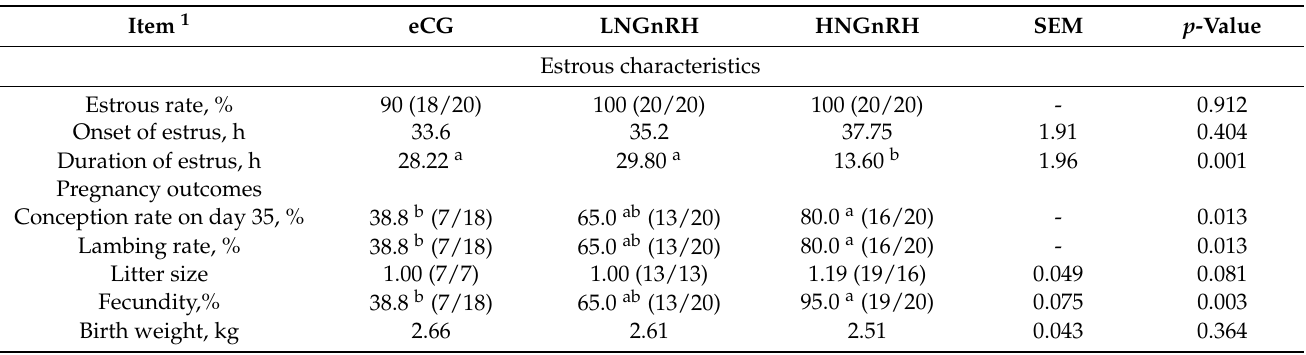
removal (Means ± standard error of means,